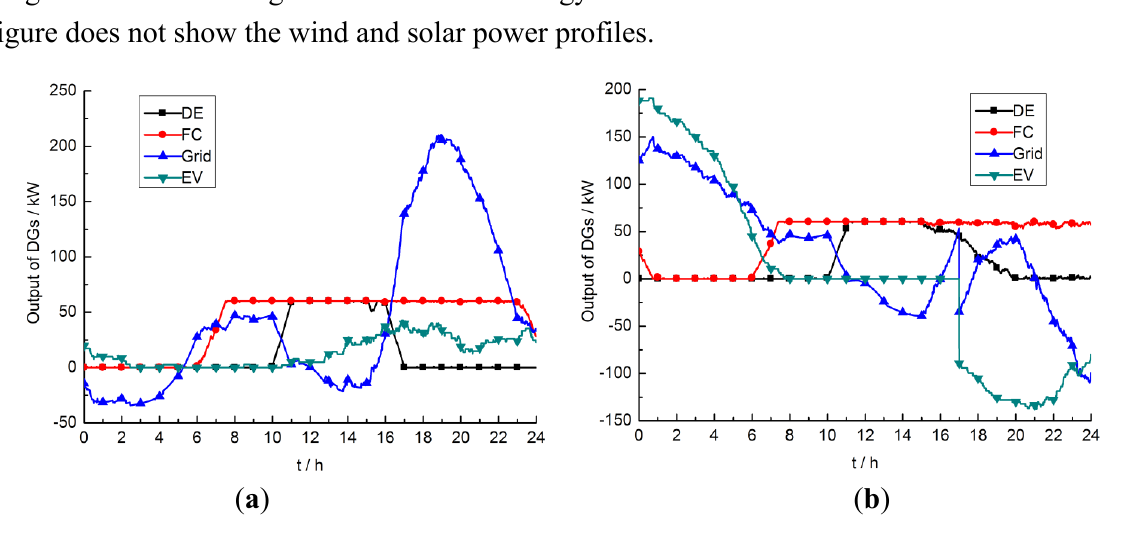
Figure 5. ( a ) Dispatch results under scheduling strategy 1; ( b ) Dispatch results under scheduling strategy